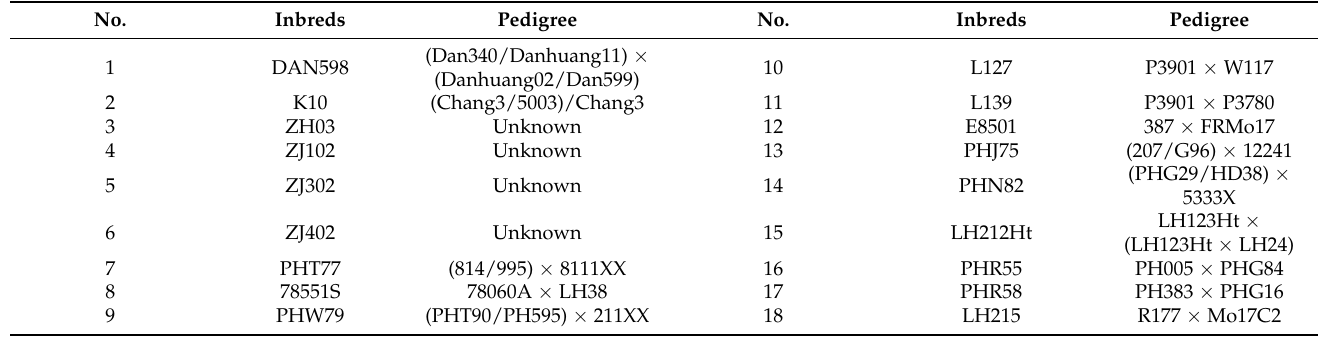
Table 1. Names and pedigree information of 18 maize tester lines used in this